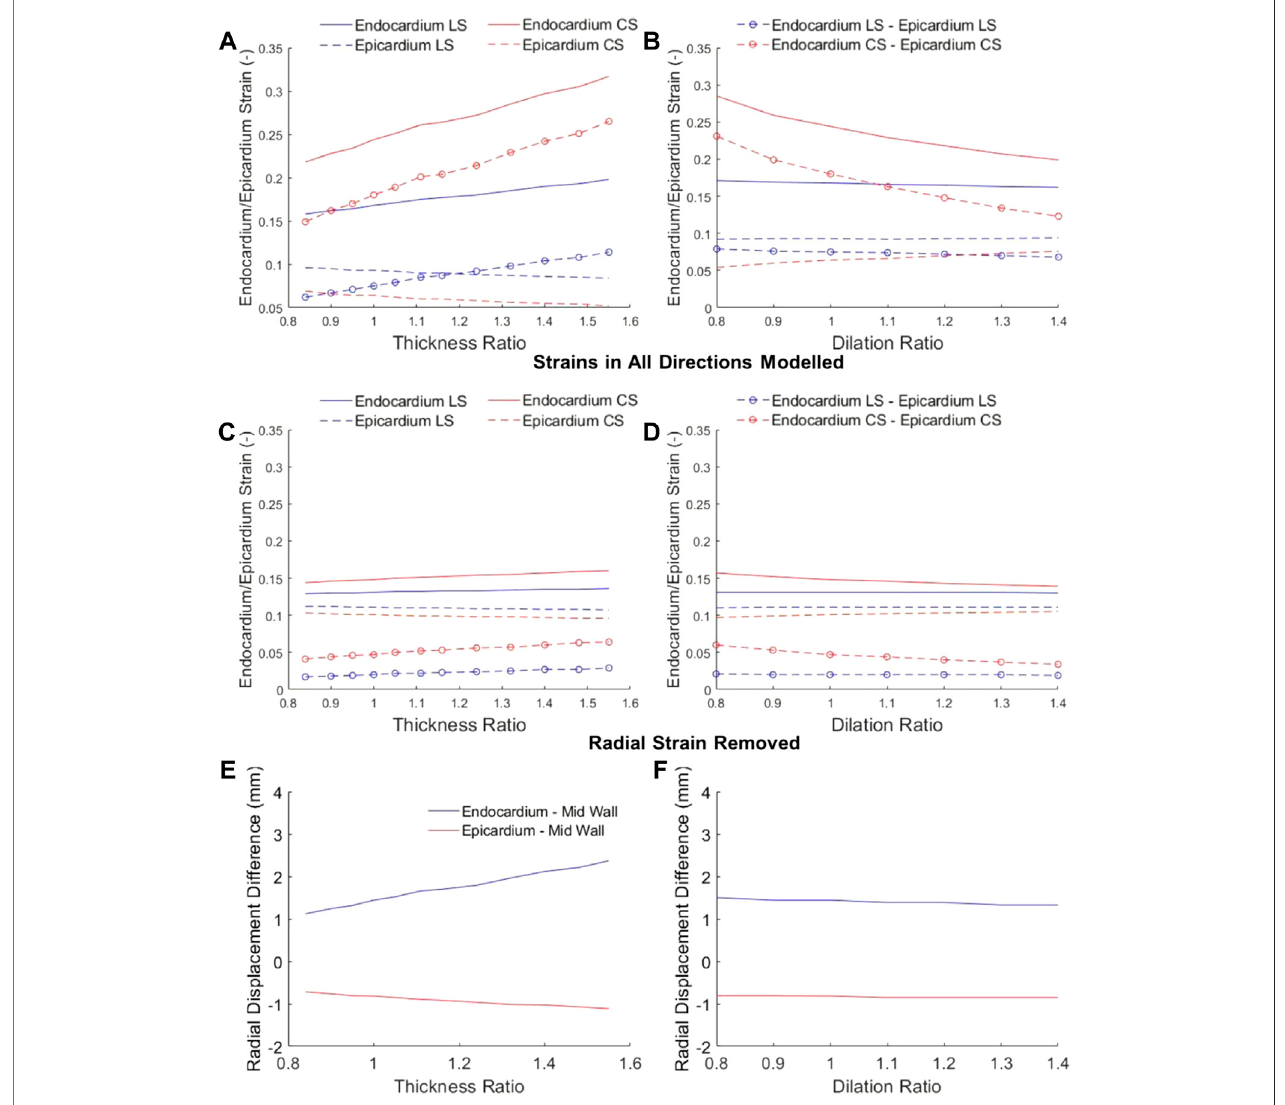
FIGURE 5 | Longitudinal strain (LS) and circumferential strain (CS) at the endocardium and epicardium at various (A,C) wall thickness ratios and (B,D) dilation ratios, wherethemid-wallED-to-ESstrainswerekeptconstantat − 0.12.In (A) and (B) ,myocardiumwasappropriatelymodelledasincompressible,andLSandCSresultedinnon- zero radial strains. In (C) and (D) , radial strains were assumed to be zero, to show that without radial displacements, there would be minimal epi-to-endo spatial strain variability. (E,F) the radial displacements of the epicardial and endocardial surfaces from the mid-wall when the heart has (E) wall thickening or (F) dilation.